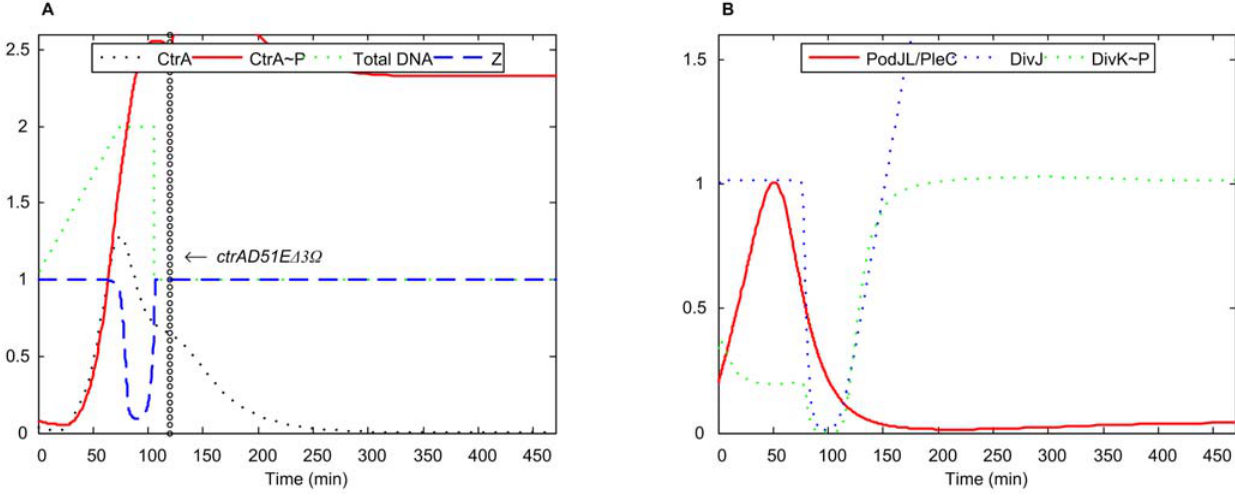
Figure 7. Simulation of double mutant ctrAD51E D 3 V . k s,ctrA-P1 = k s,ctrA-P2 =0, k trans,CtrA , P =0, k 9 =0.064 (40% of WT) was added to [CtrA , P] equation, k